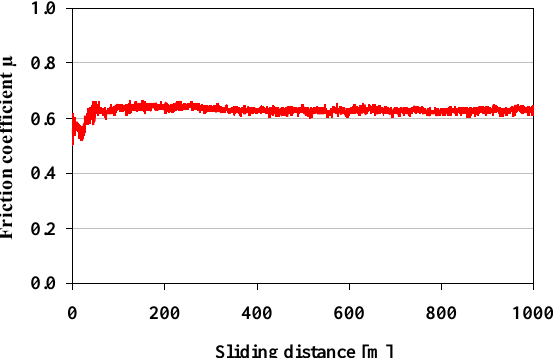
Figure 15. Dependence of the friction coefficient on the sliding distance during the wear test for the AlCrN + CrCN coating.